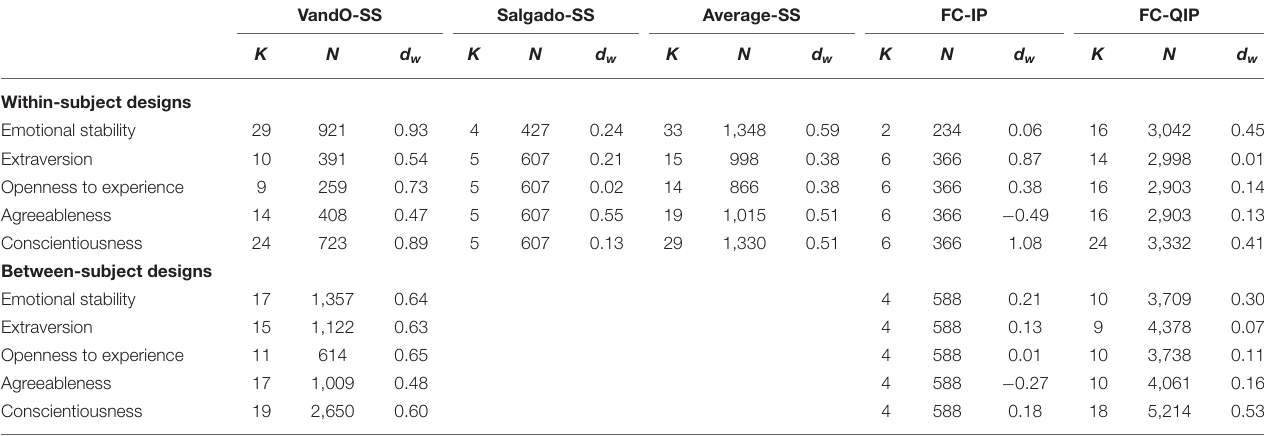
TABLE 6 | Comparison between the meta-analyses of the resistance to faking of FC and SS personality inventories in experimental contexts. VandO-SS Salgado-SS Average-SS